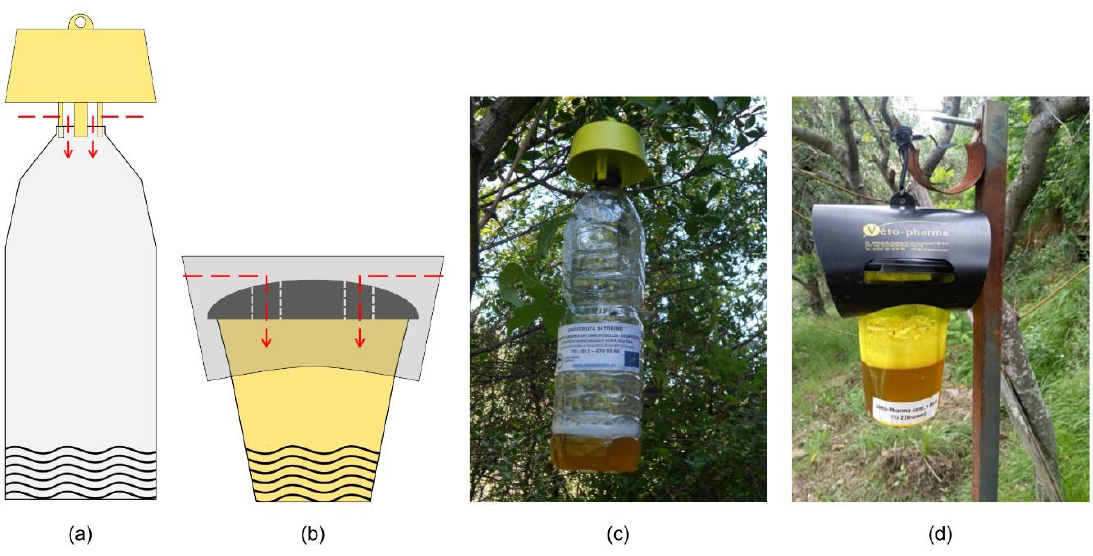
Figure 1. Traps tested in the study: ( a ) Scheme of the bottle trap equipped with the yellow cap (T); ( b ) scheme of the VespaCatch trap (V); ( c ) photo of the bottle trap with the yellow cap (T); ( d ) photo of the VespaCatch trap (V). The red arrows in the two schemes highlight the access route used by the hornets for entering the traps. Both models of traps were filled with beer (B) as bait (trap–bait combination named respectively TB and VB) or VespaCatch (V) attractant (trap–bait combination named respectively TV and VV) for a full factorial experiment.